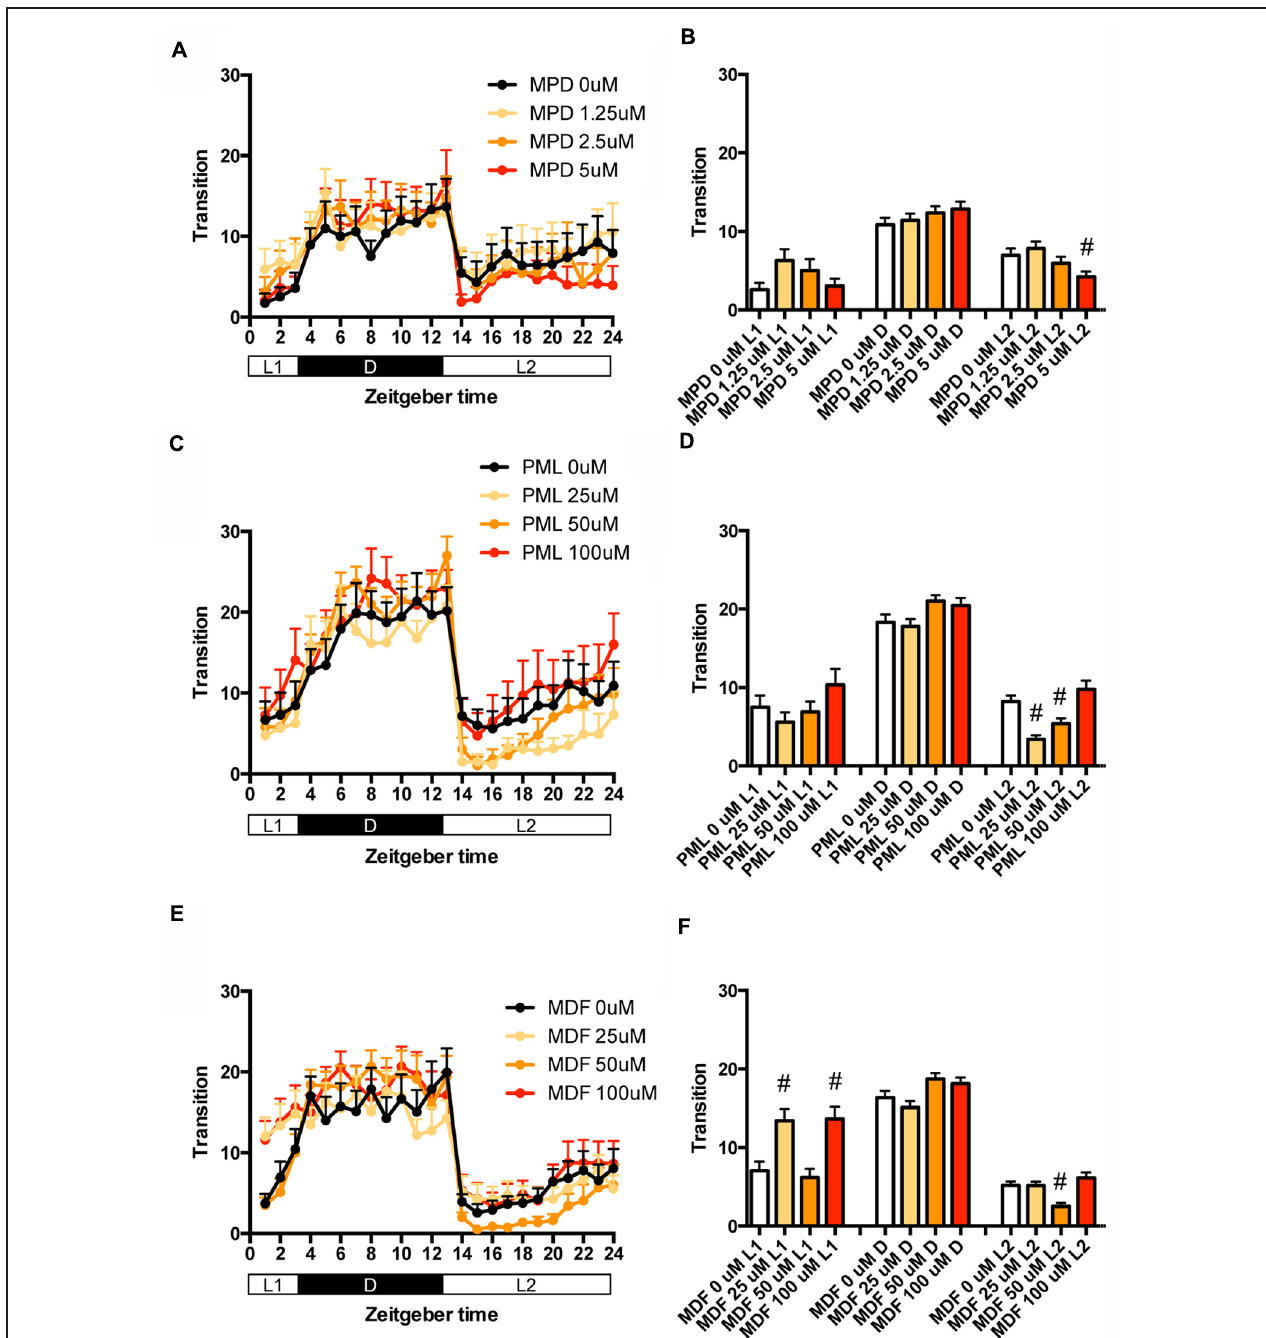
FIGURE 5 | Effects of methylphenidate, pemoline, and modafinil on the transition between rest and active states of zebrafish. The number of transitions of zebrafish treated with methylphenidate (A) , pemoline (C) , and modafinil (E) from 9 to 10 dpf is indicated during the hour. The number of transitions of zebrafish treated with methylphenidate (B) , pemoline (D) , and modafinil (F) from 9 to 10 dpf is indicated as during L1, D, and L2. The data are represented as means with the standard error of mean. # p < 0.05 vs. control.